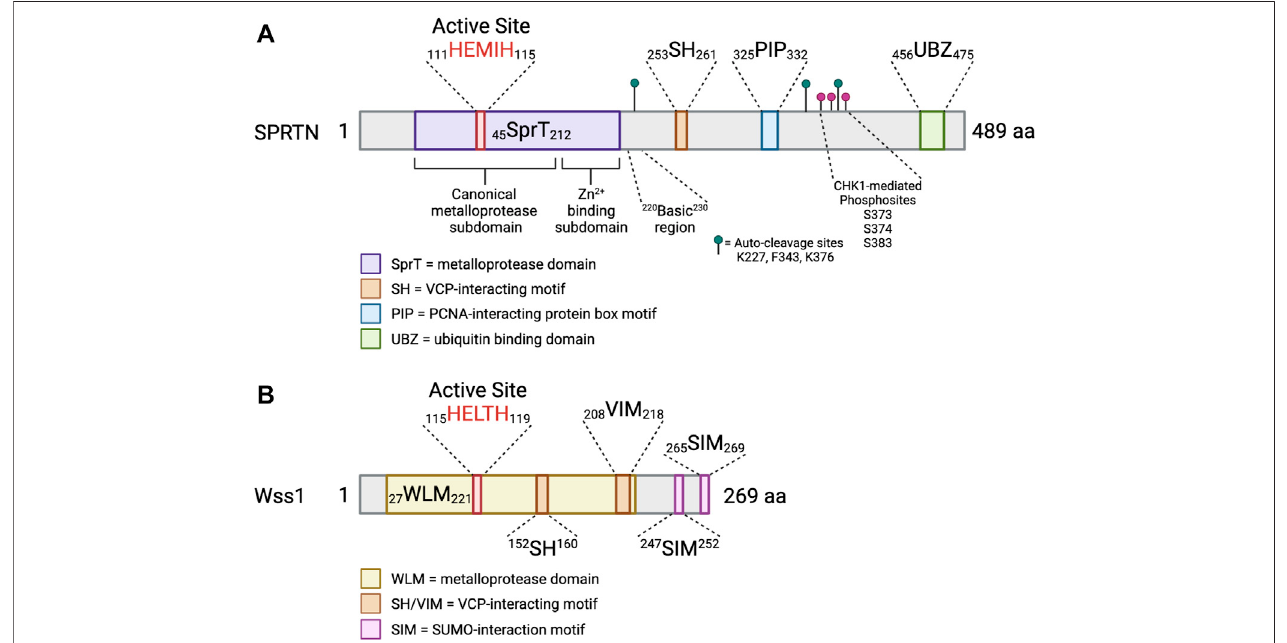
FIGURE 3 | SPRTN is a multidomain protein. Schematic depicting the domains of SPRTN and Wss1 metalloproteases. Small numbers represent aa ranges of indicated domains. (A) SprT = metalloprotease domain; SH = VCP-interacting motif; PIP = PCNA-interacting protein box motif; UBZ = ubiquitin binding domain. The SprT domain can be subdivided into the canonical metalloprotease domain (aa 45 – 166), which contains the conserved HEXXH active site, and the Zn 2+ -binding subdomain which assists in substrate cleavage and has secondary DNA binding function (aa 167 – 212) (Li et al., 2019). The basic region (aa 220 – 230) is a critical DNA binding region (Toth et al., 2017; Li et al., 2019). Identi fi ed SPRTN auto-cleavage sites are indicated with green lollipops (Vaz et al., 2016), and identi fi ed phosphosites are indicated with magenta lollipops (Halder et al., 2019). (B) WLM = metalloprotease domain; SH/VIM = VCP-interacting motif; SIM = SUMO-interaction motif (Vaz et al., 2017). Created in